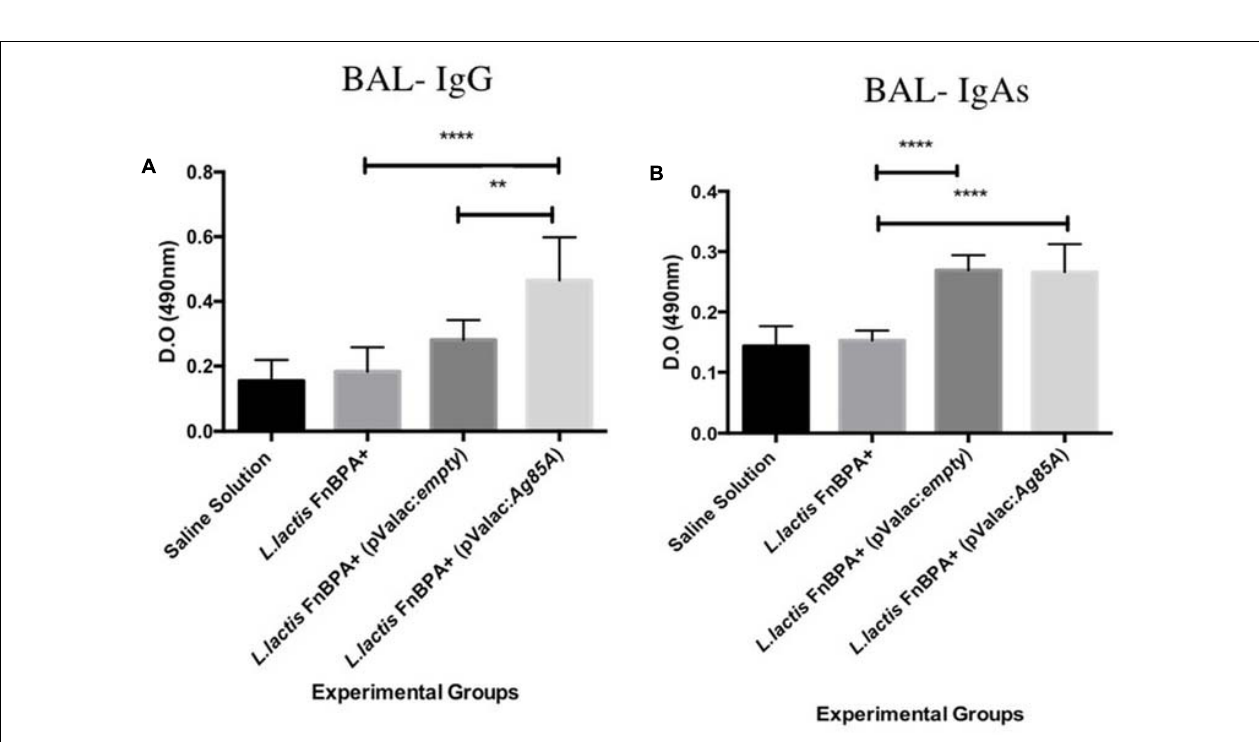
FIGURE 6 | Antibodies production in bronchoalveolar lavage (BAL) of mice intranasally immunized. Production level of (A) IgG anti-Ag85A and (B) sIgA anti-Ag85A. Experimental groups: Saline Solution (negative control), L. lactis FnBPA + (negative control), L. lactis FnBPA + (pValac: empty ), and L. lactis FnBPA (pValac: Ag85A ). Data are shown as the mean ± SD Two individual experiments were performed, five animals were used in each group for each individual protocol and each animal was analyzed individually. p -value: ∗ p < 0.05, ∗∗ p < 0.01, ∗∗∗ p < 0.001, and ∗∗∗∗ p < 0.0001.